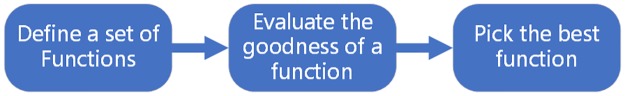
General three steps of deep learning.